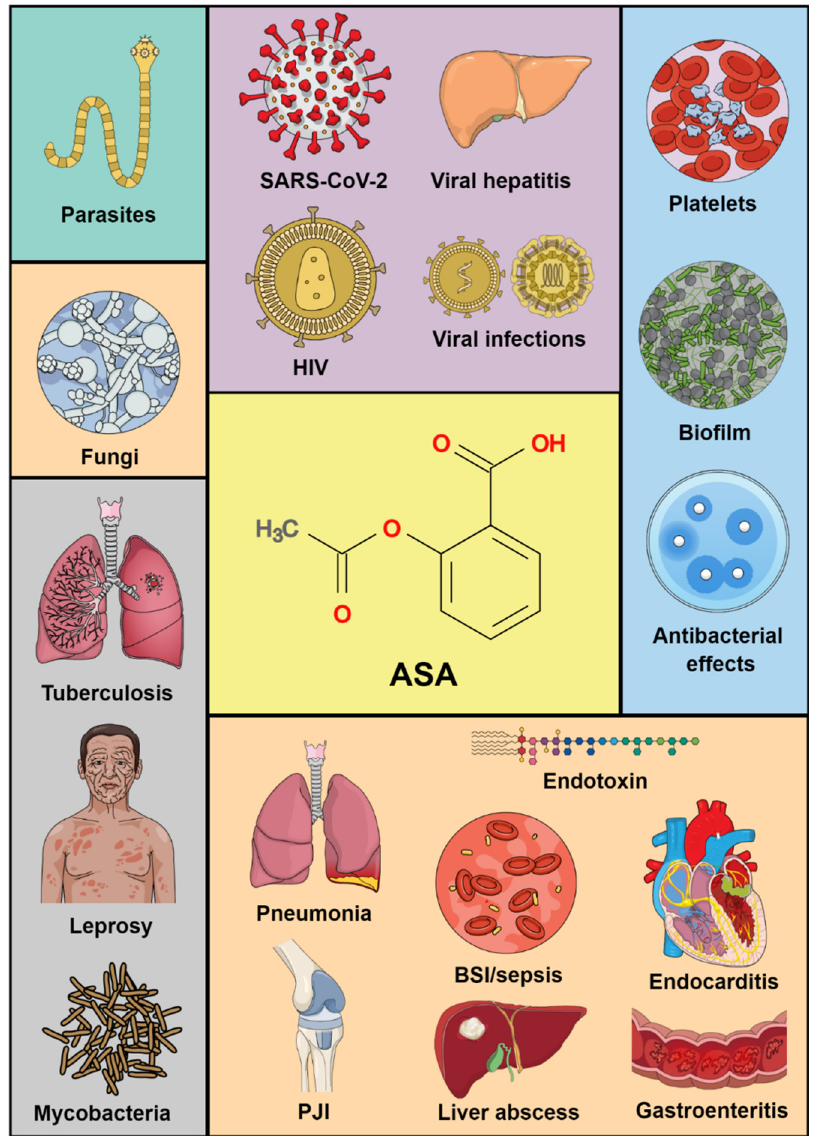
Figure 1. Potential targets of acetylsalicylic acid in infectious diseases. ASA: acetylsalicylic acid; BSI: bloodstream infection; HIV: human immunodeficiency virus; PJI: prosthetic joint infections.